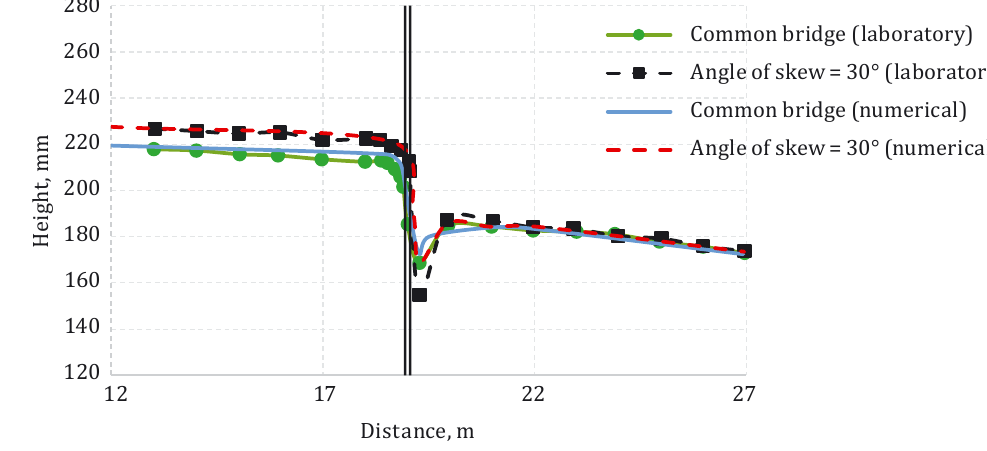
Figure 8. Water level profiles obtained from the results of the